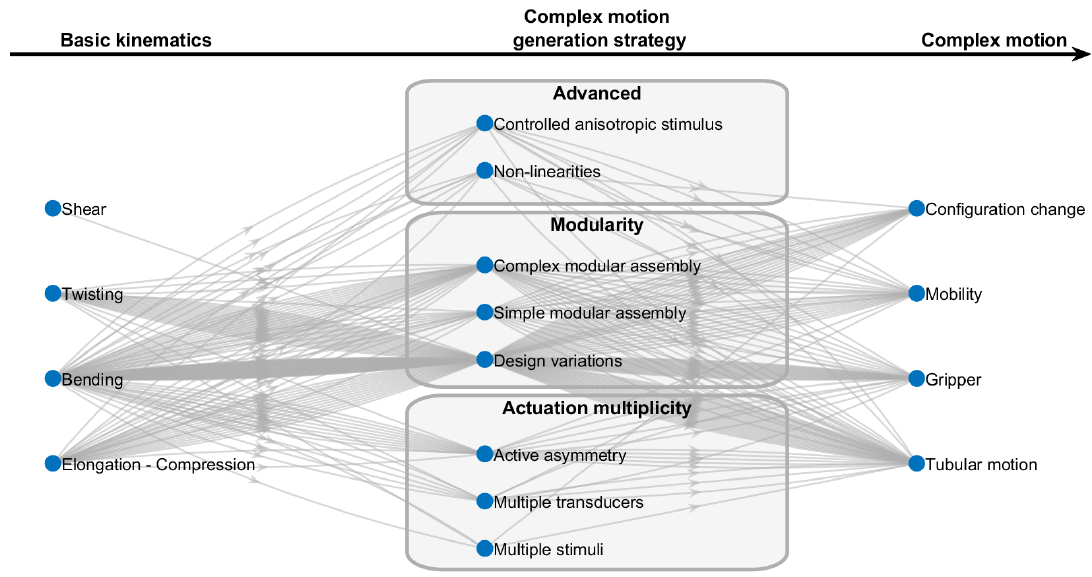
Figure 10. Roadmap towards complex motion generation: one soft robot is represented by a set of arrows. Complex motions can be generated using several strategies in